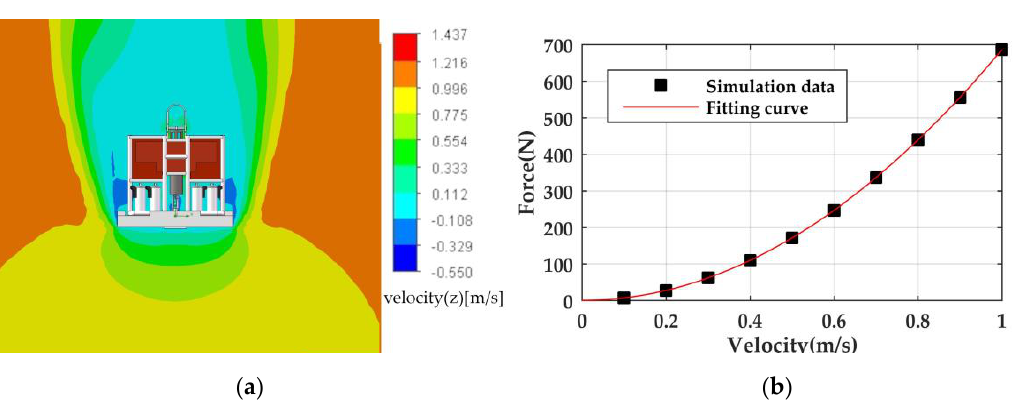
Figure 2. ( a ) Cut plot when the incoming flow velocity is 1 m/s; ( b ) damping force quadratic function curve of the lander.